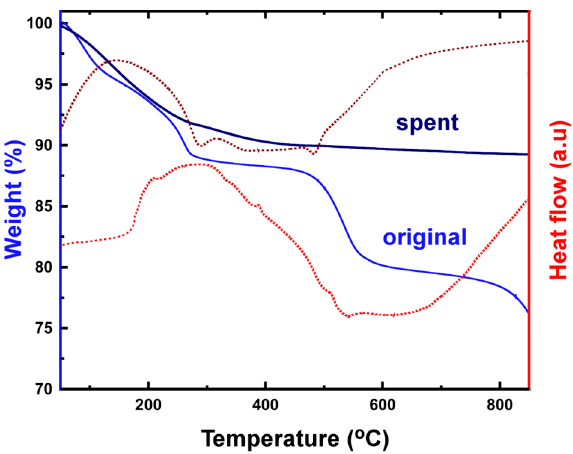
Figure 3. TG-DTA curves of spent and corresponding original